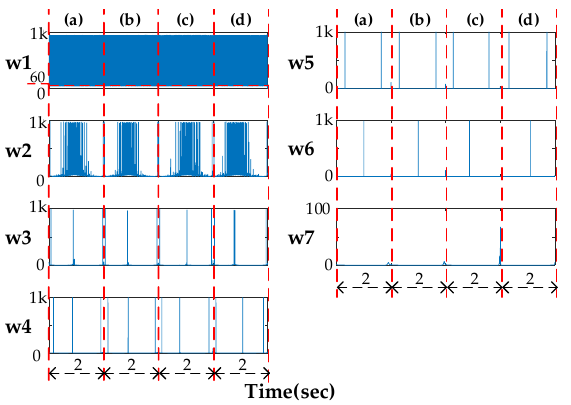
Figure 6. The EMD of current signal. ( a ) Normal motor, ( b ) bearing fault, ( c ) interturn short circuit, ( d ) broken rotor bar.